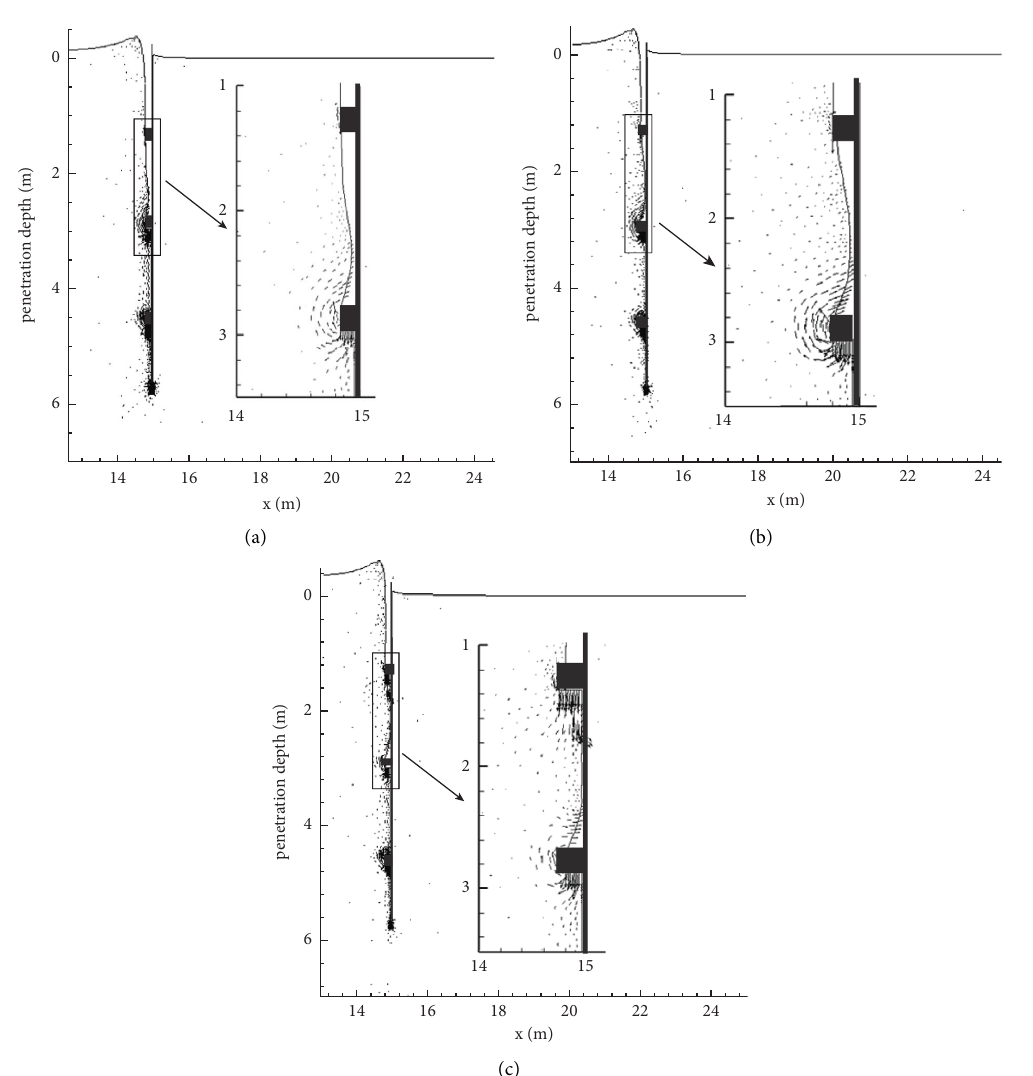
Figure 7: Effect of stiffener width on soil movement. (a) b / t � 2.0. (b) b / t � 3.0. (c) b / t � 5.0.